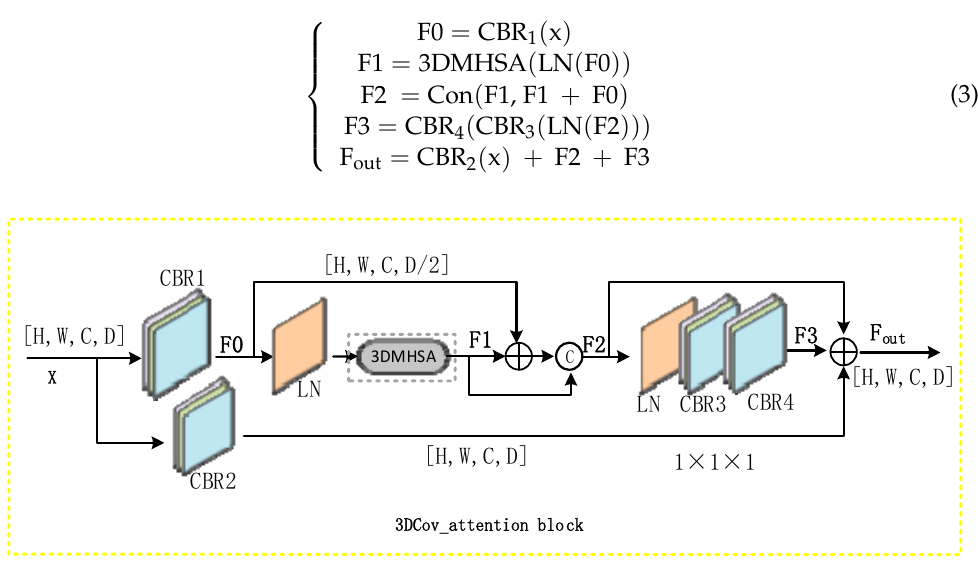
Figure 4. 3D Convolutional Neural Network with Self-Attention